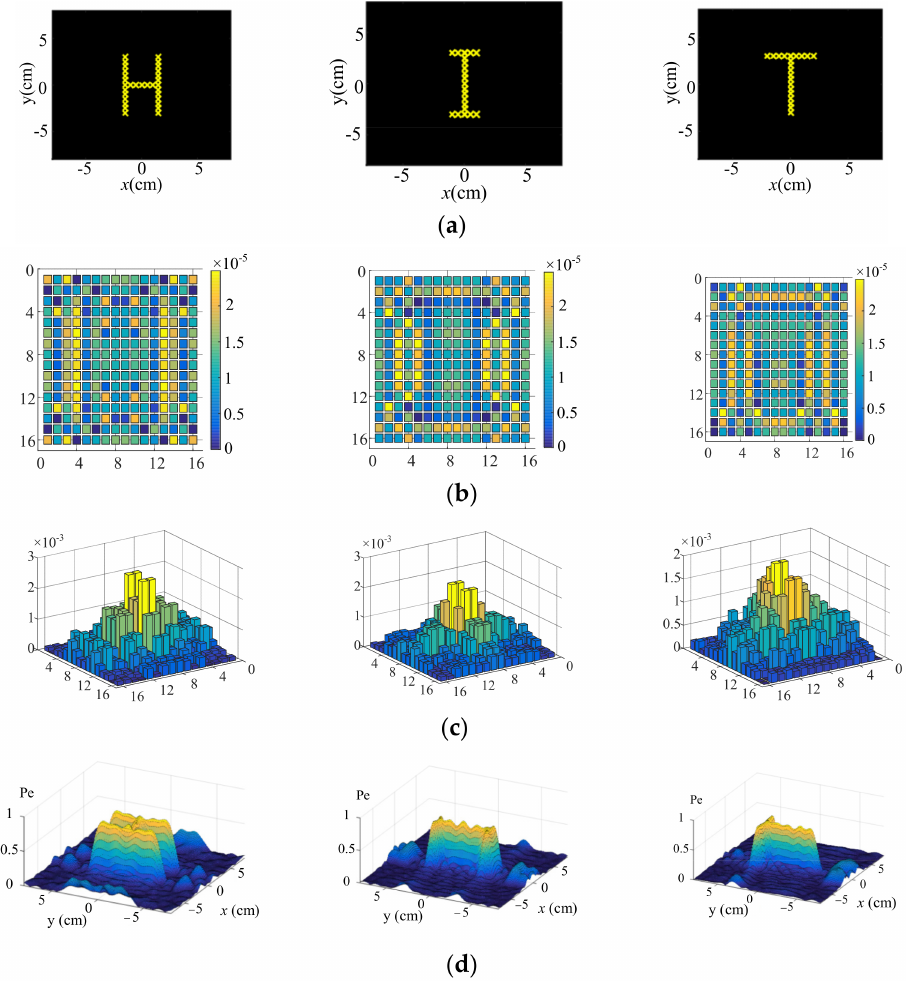
Figure 5. Simulation for letters H, I and T. ( a ) demonstrates the desired focal letters of H, I and T, respectively. ( b – d ) show the corresponding phase distribution, amplitude distribution and ultrasound pressure distribution,